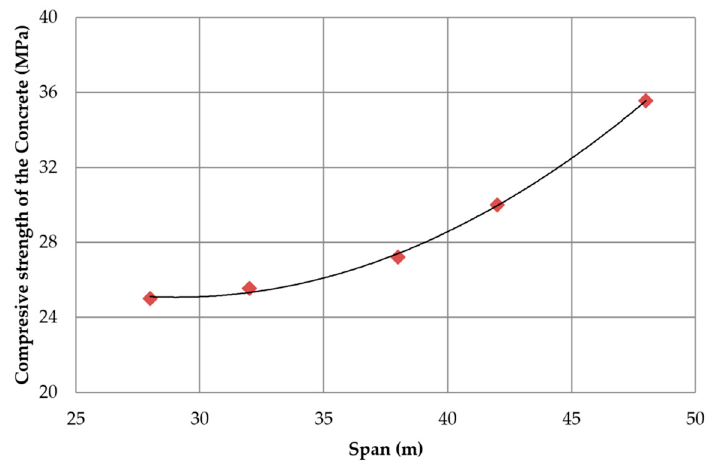
Figure 11. Average compressive strength for different span lengths.